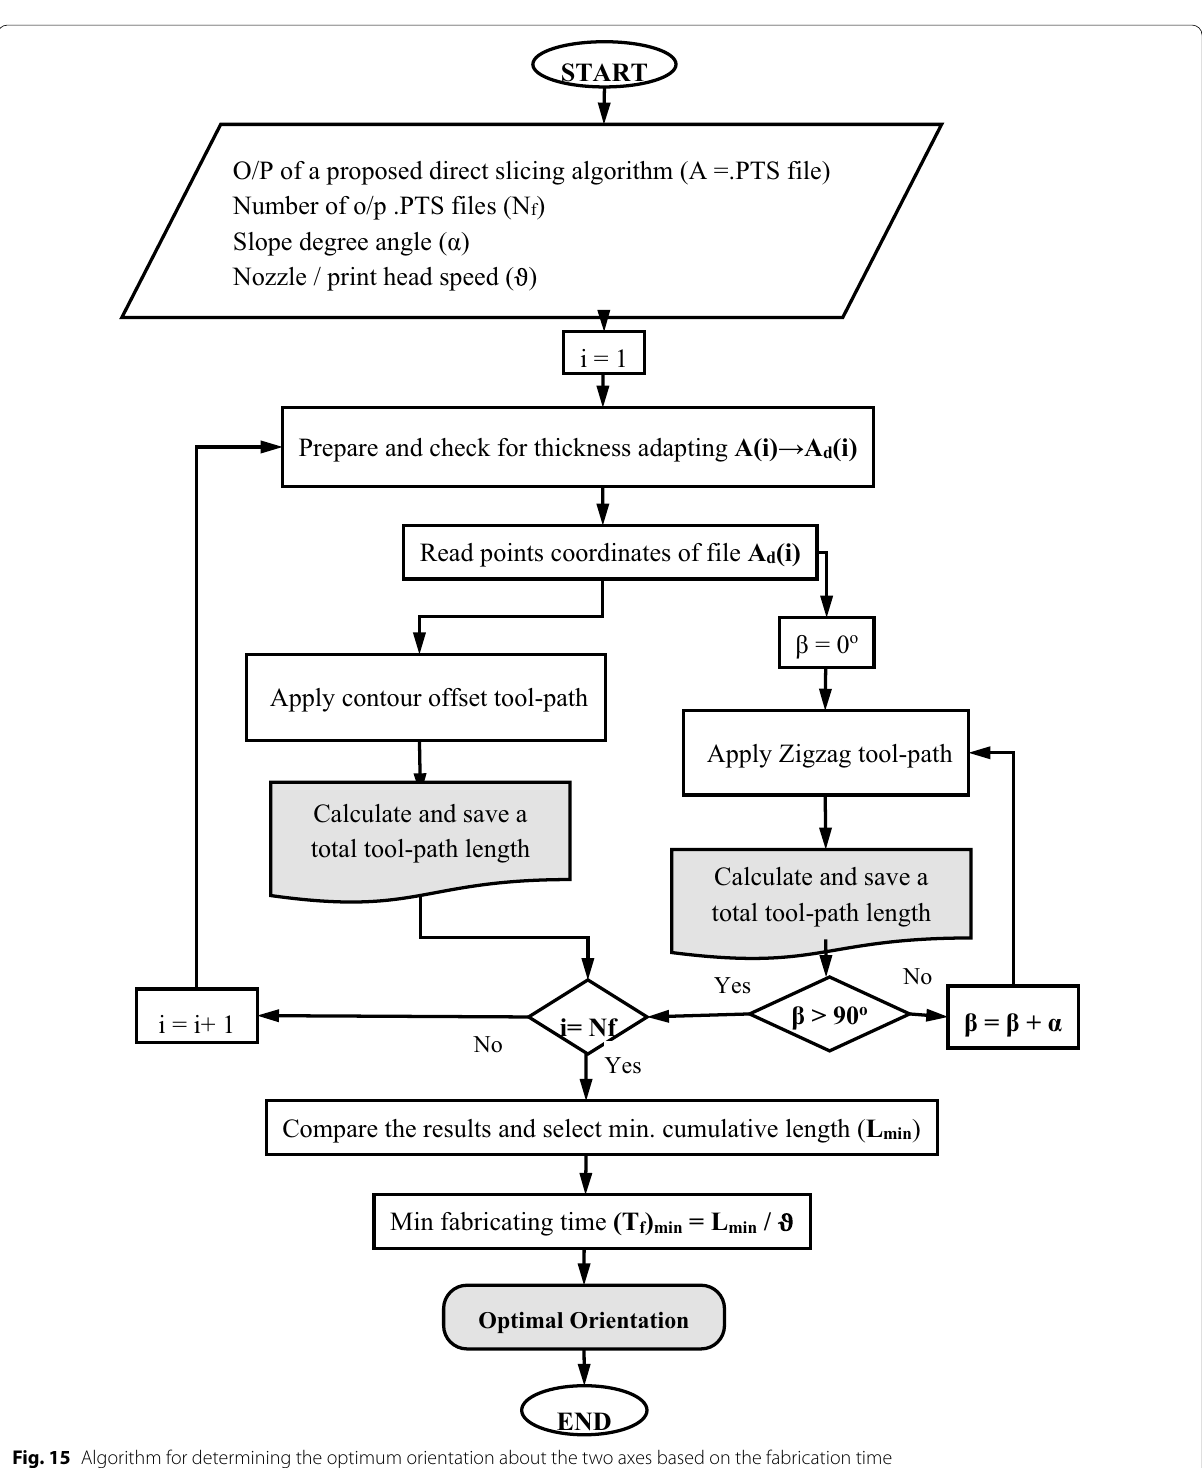
Fig. 15 Algorithm for determining the optimum orientation about the two axes based on the fabrication